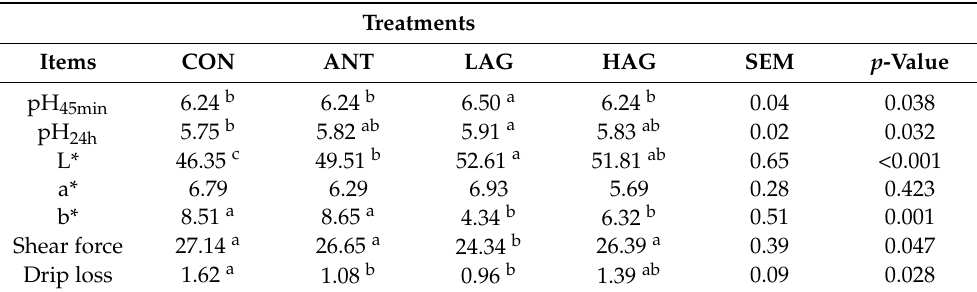
Table 3. Effects of Astragalus-Glycyrrhiza polysaccharides on meat quality.